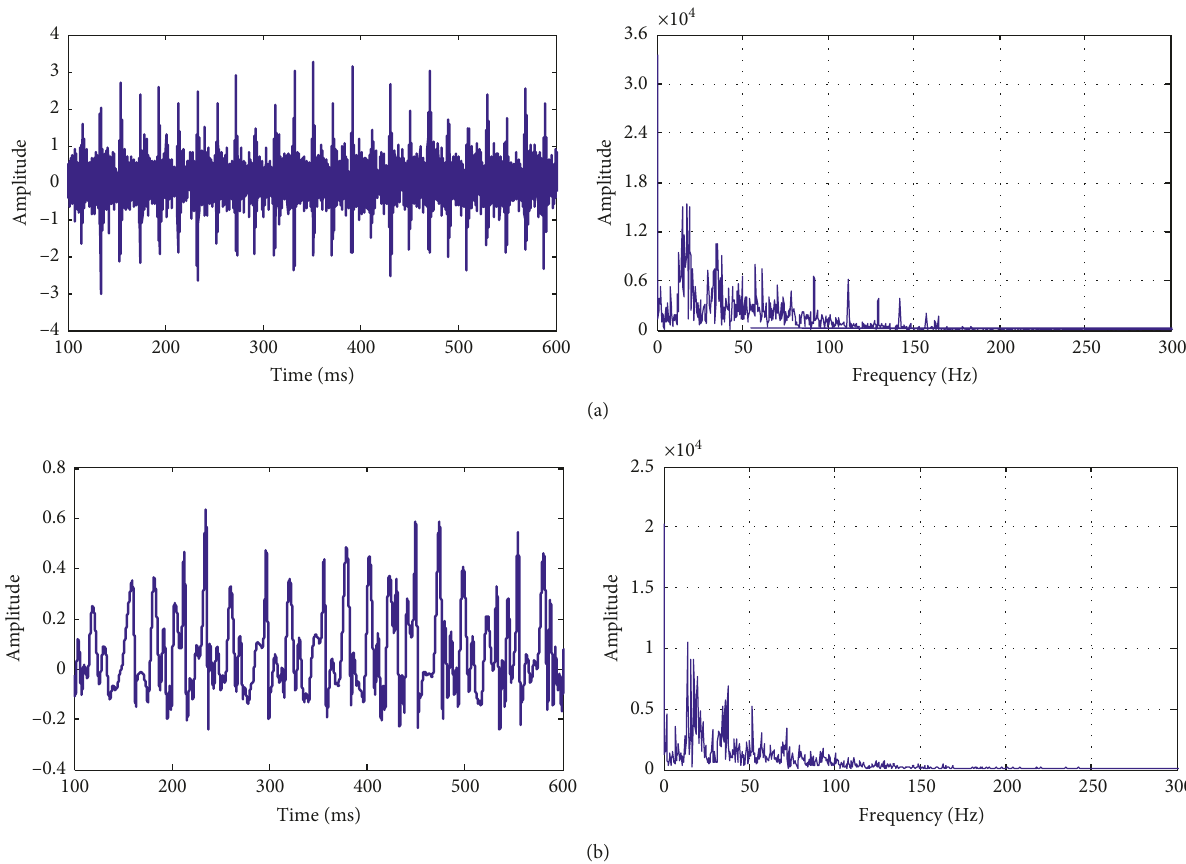
Figure 19: Vertical vibration amplitude signals and their frequency diagram on bearing with pedestal looseness coupled with rub-impact (looseness clearance 0.002m). (a) Vibration amplitude signals and its frequency diagram. (b) Denosing vibration amplitude signals and its (cid:31) frequency diagram.